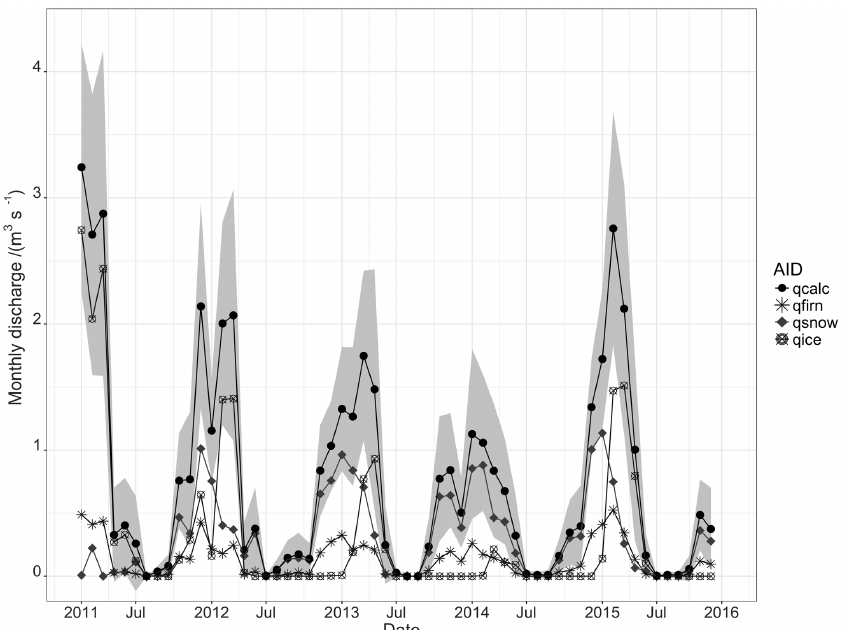
Figure 14. Time series of meltwater discharge from GMM run November 2010 to November 2015 for the Fourcade Glacier, catchment of the Potter Cove, separated into the different source areas (AID) of snow, firn, ice and rock terrain ( q snow , q firn , q ice and q rock ). The complete simulated meltwater discharge ( q calc ) is shown in black solid circle with the standard deviation of the time series in grey envelope.